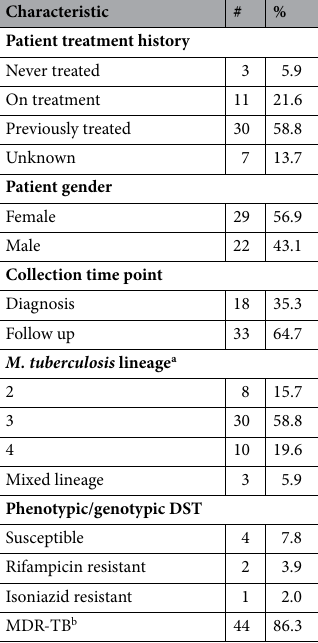
Table 1. Patient demographic and genotypic data of the 51 M. tuberculosis isolates. DST drug susceptibility test, MDR-TB multidrug-resistant TB. a There are five mixed infections, with three mixed lineage and two same lineage infections (see Supplementary Table S1). b MDR-TB or MDR-TB+, with 5 mixed infections involving MDR-TB (see Supplementary Table